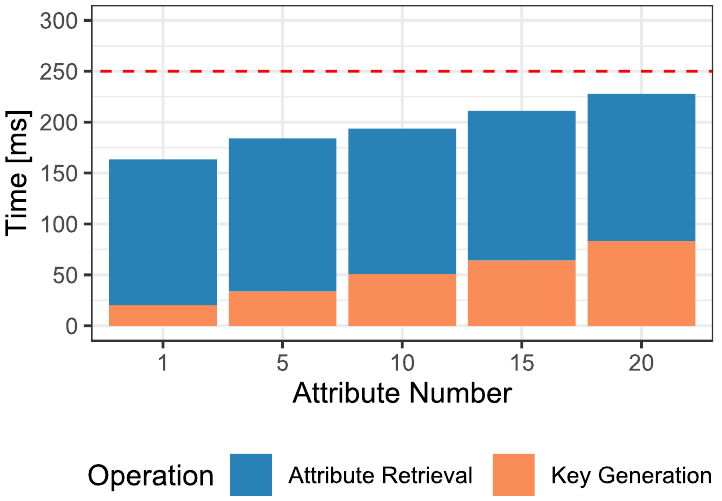
Figure 5. Time in ms to generate SK ABE with attribute